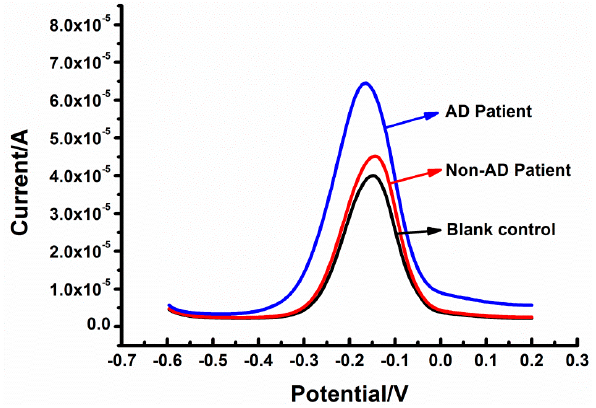
Figure 8. The dpvs of tau381 in human serum samples from blank control, non- and Alzheimer (cid:48) s